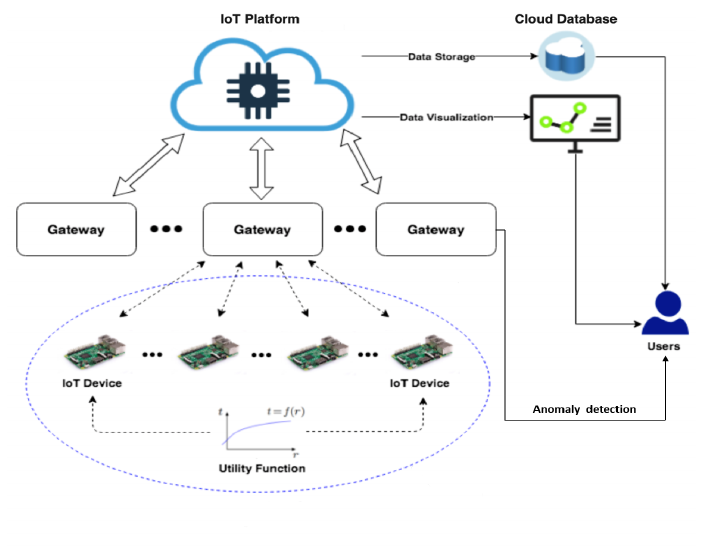
Figure 1. Schematic diagram of the system architecture